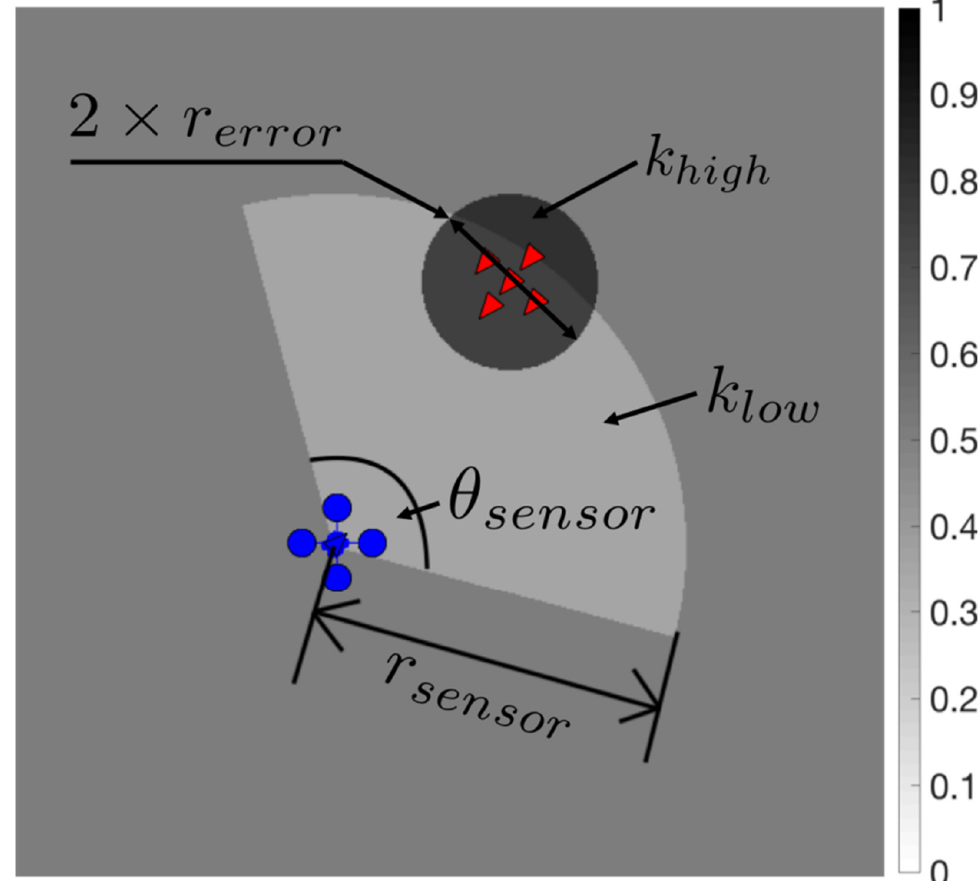
Figure 2. Illustration of the sensor model. The greyscale bar indicates the probability of a target occupying the cells, darker indicates higher probability.